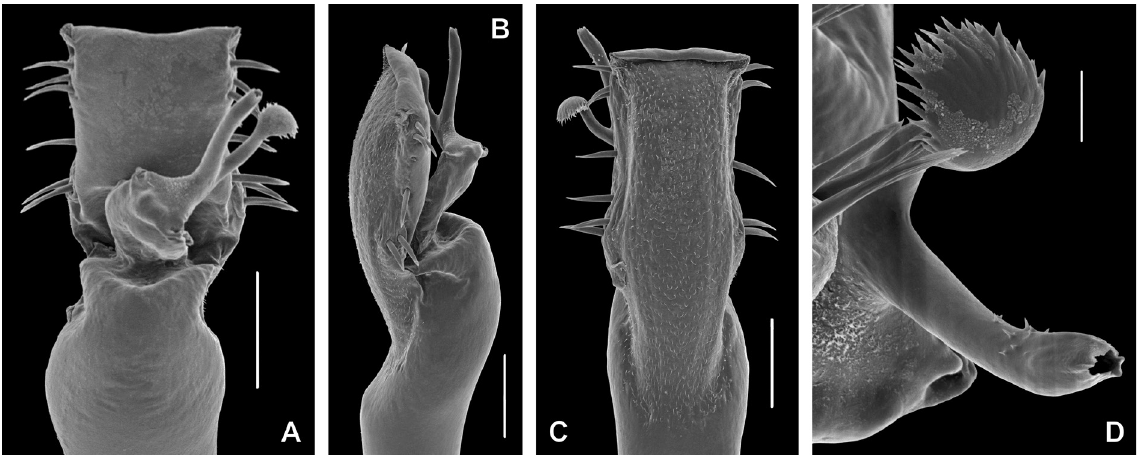
Fig. 20. Lacronia tenuis (Roewer, 1917) comb. nov., ♂ (MNRJ 5533 ꜝ ), penis, distal part. A . Dorsal view. B . Left lateral view. C . Ventral view. D . Detail of stylus and ventral process, dorso-lateral view. Scale bars: A–C = 100 μm; D = 20